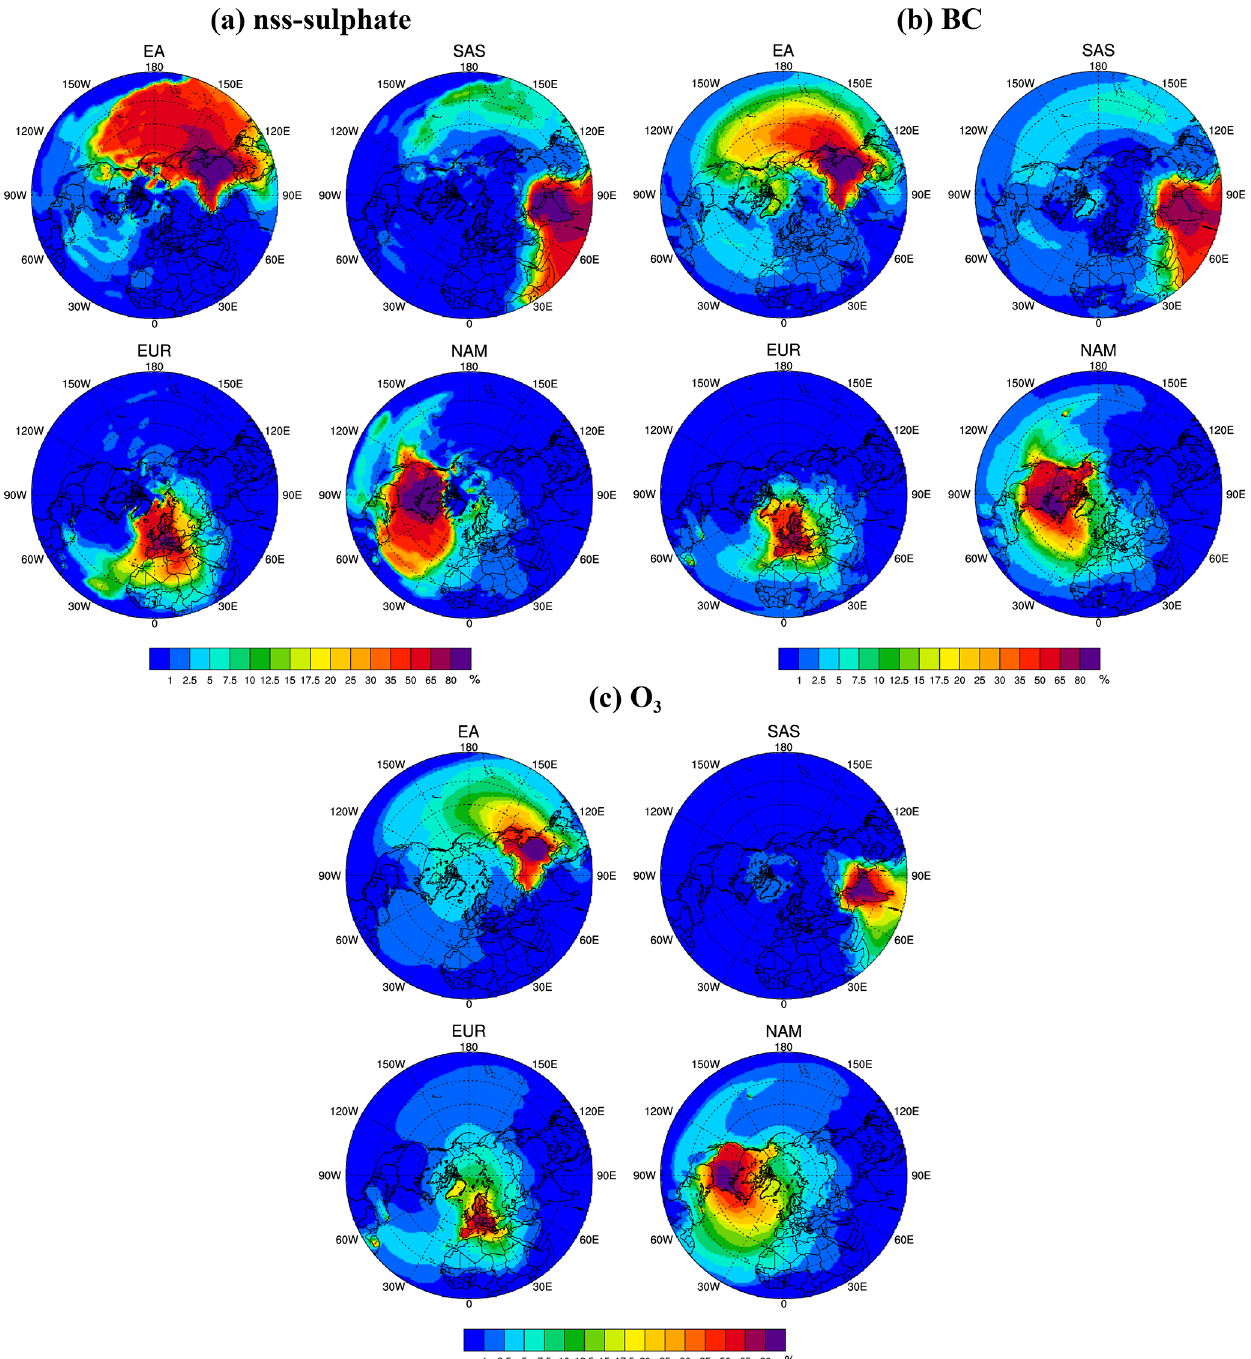
Figure 15. Spatial distribution of source region contributions to (a) nss-sulfate; (b) BC concentration within the PBL and (c) O 3 (%) in the surface